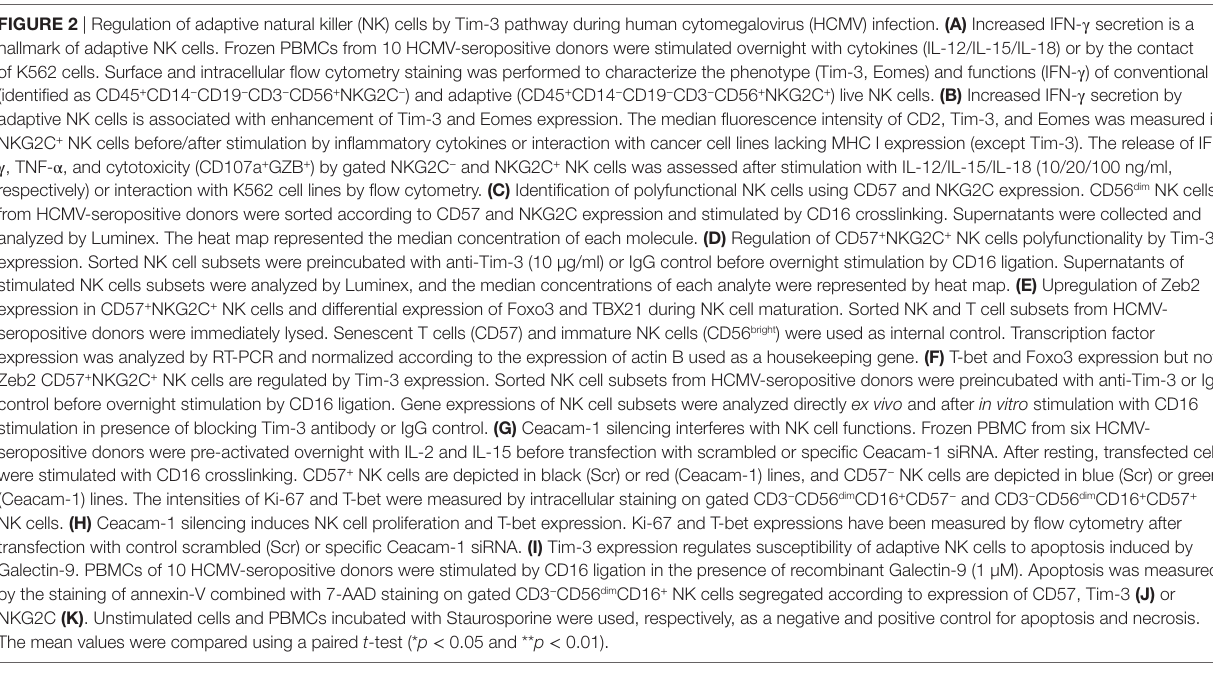
FigUre 2 | Regulation of adaptive natural killer (NK) cells by Tim-3 pathway during human cytomegalovirus (HCMV) infection. (a) Increased IFN- γ secretion is a hallmark of adaptive NK cells. Frozen PBMCs from 10 HCMV-seropositive donors were stimulated overnight with cytokines (IL-12/IL-15/IL-18) or by the contact of K562 cells. Surface and intracellular flow cytometry staining was performed to characterize the phenotype (Tim-3, Eomes) and functions (IFN- γ ) of conventional (identified as CD45 + CD14 − CD19 − CD3 − CD56 + NKG2C − ) and adaptive (CD45 + CD14 − CD19 − CD3 − CD56 + NKG2C + ) live NK cells. (B) Increased IFN- γ secretion by adaptive NK cells is associated with enhancement of Tim-3 and Eomes expression. The median fluorescence intensity of CD2, Tim-3, and Eomes was measured in NKG2C + NK cells before/after stimulation by inflammatory cytokines or interaction with cancer cell lines lacking MHC I expression (except Tim-3). The release of IFN- γ , TNF- α , and cytotoxicity (CD107a + GZB + ) by gated NKG2C − and NKG2C + NK cells was assessed after stimulation with IL-12/IL-15/IL-18 (10/20/100 ng/ml, respectively) or interaction with K562 cell lines by flow cytometry. (c) Identification of polyfunctional NK cells using CD57 and NKG2C expression. CD56 dim NK cells from HCMV-seropositive donors were sorted according to CD57 and NKG2C expression and stimulated by CD16 crosslinking. Supernatants were collected and analyzed by Luminex. The heat map represented the median concentration of each molecule. (D) Regulation of CD57 + NKG2C + NK cells polyfunctionality by Tim-3 expression. Sorted NK cell subsets were preincubated with anti-Tim-3 (10 µg/ml) or IgG control before overnight stimulation by CD16 ligation. Supernatants of stimulated NK cells subsets were analyzed by Luminex, and the median concentrations of each analyte were represented by heat map. (e) Upregulation of Zeb2 expression in CD57 + NKG2C + NK cells and differential expression of Foxo3 and TBX21 during NK cell maturation. Sorted NK and T cell subsets from HCMV- seropositive donors were immediately lysed. Senescent T cells (CD57) and immature NK cells (CD56 bright ) were used as internal control. Transcription factor expression was analyzed by RT-PCR and normalized according to the expression of actin B used as a housekeeping gene. (F) T-bet and Foxo3 expression but not Zeb2 CD57 + NKG2C + NK cells are regulated by Tim-3 expression. Sorted NK cell subsets from HCMV-seropositive donors were preincubated with anti-Tim-3 or IgG control before overnight stimulation by CD16 ligation. Gene expressions of NK cell subsets were analyzed directly ex vivo and after in vitro stimulation with CD16 stimulation in presence of blocking Tim-3 antibody or IgG control. (g) Ceacam-1 silencing interferes with NK cell functions. Frozen PBMC from six HCMV- seropositive donors were pre-activated overnight with IL-2 and IL-15 before transfection with scrambled or specific Ceacam-1 siRNA. After resting, transfected cells were stimulated with CD16 crosslinking. CD57 + NK cells are depicted in black (Scr) or red (Ceacam-1) lines, and CD57 − NK cells are depicted in blue (Scr) or green (Ceacam-1) lines. The intensities of Ki-67 and T-bet were measured by intracellular staining on gated CD3 − CD56 dim CD16 + CD57 − and CD3 − CD56 dim CD16 + CD57 + NK cells. (h) Ceacam-1 silencing induces NK cell proliferation and T-bet expression. Ki-67 and T-bet expressions have been measured by flow cytometry after transfection with control scrambled (Scr) or specific Ceacam-1 siRNA. (i) Tim-3 expression regulates susceptibility of adaptive NK cells to apoptosis induced by Galectin-9. PBMCs of 10 HCMV-seropositive donors were stimulated by CD16 ligation in the presence of recombinant Galectin-9 (1 µM). Apoptosis was measured by the staining of annexin-V combined with 7-AAD staining on gated CD3 − CD56 dim CD16 + NK cells segregated according to expression of CD57, Tim-3 (J) or NKG2C (K) . Unstimulated cells and PBMCs incubated with Staurosporine were used, respectively, as a negative and positive control for apoptosis and necrosis. The mean values were compared using a paired t -test (* p < 0.05 and ** p <